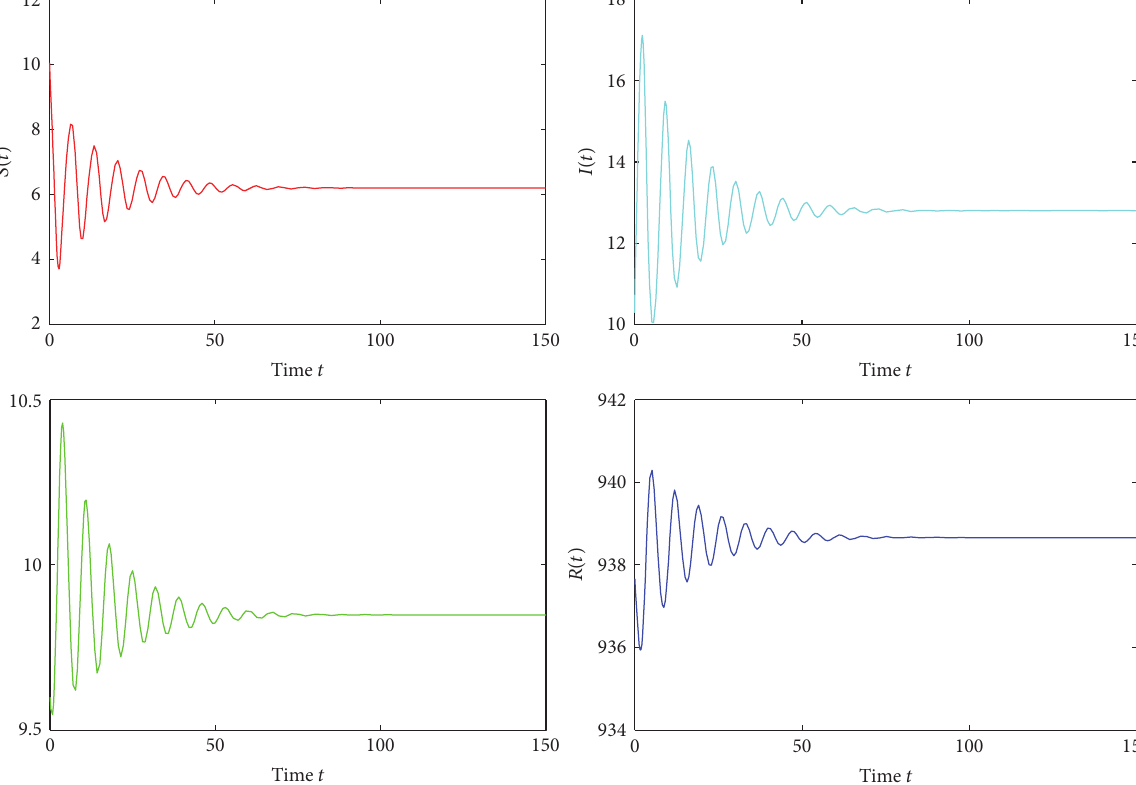
Figure 13: The trajectory of 𝑆 , 𝐼 , 𝑄 , and 𝑅 when 𝜏 1 = 0.785 < 0.8903 = 𝜏 󸀠 10 and 𝜏 2 = 1.05 .